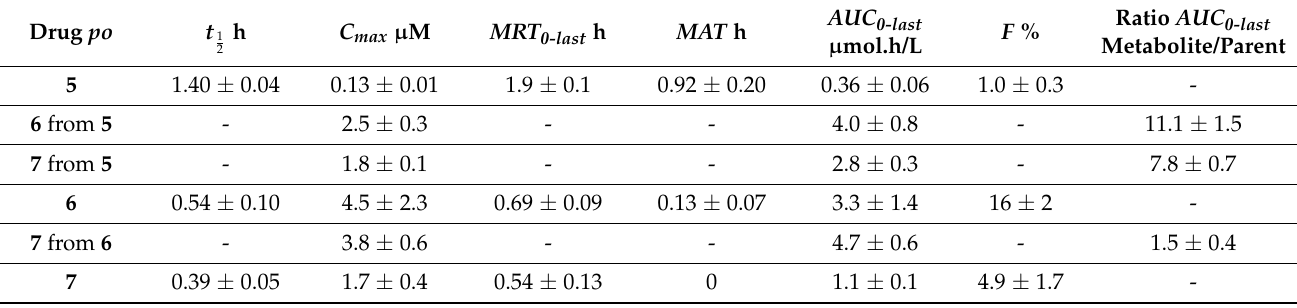
Table 4. Pharmacokinetic parameters calculated from the oral administration ( po ) of 50 mg/kg artemiside 5 , artemisox 6 , and artemisone 7 to male C57/BL6 mice together with their respective metabolites formed in situ a . Drug